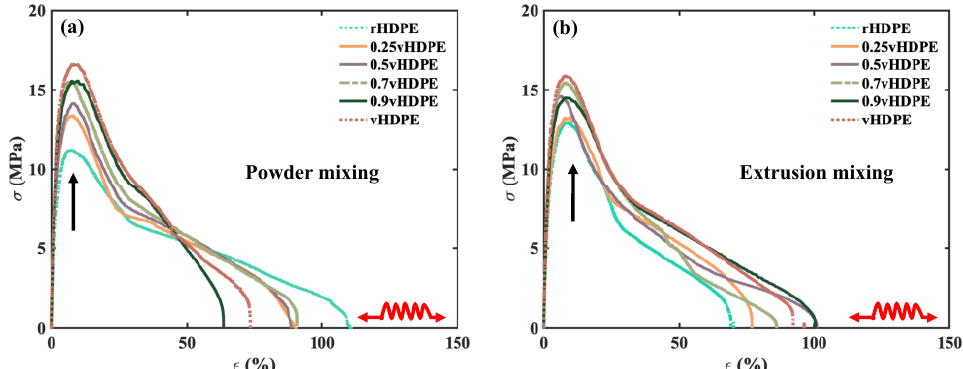
Figure 4. Effect of vHDPE content on the tensile stress–strain curves of the blends for both processing methods: ( a ) powder mixing and ( b ) extrusion mixing. Tensile tests are performed at a strain rate of 5 mm/min. The red springs indicate the oscillation of elongation at break.